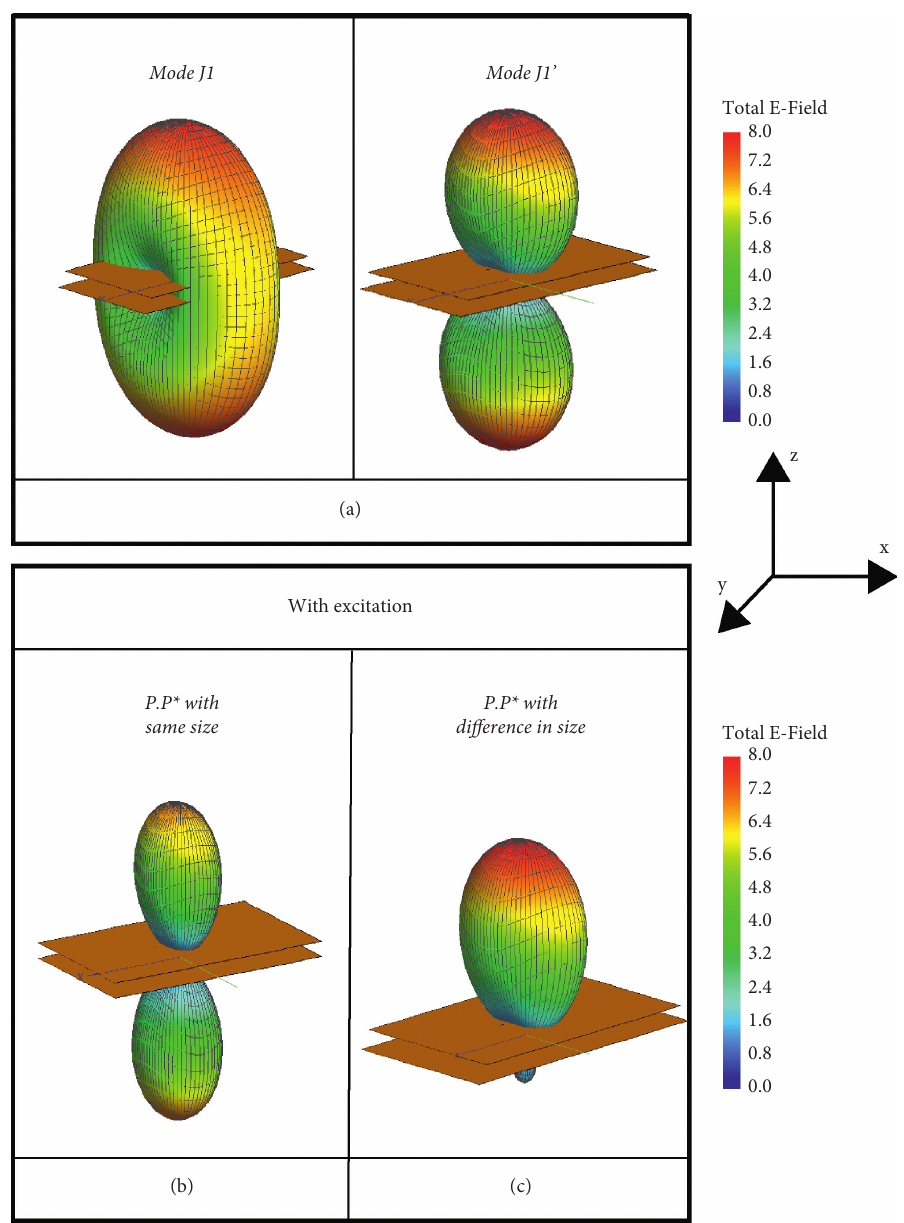
Figure 5: Radiation pattern associated to (a) fundamental modes J 1 and J 1 ′ ; (b) parallel plates ( P . P ∗ ) with the same size; and (c) parallel plates ( P . P ∗ ) with different